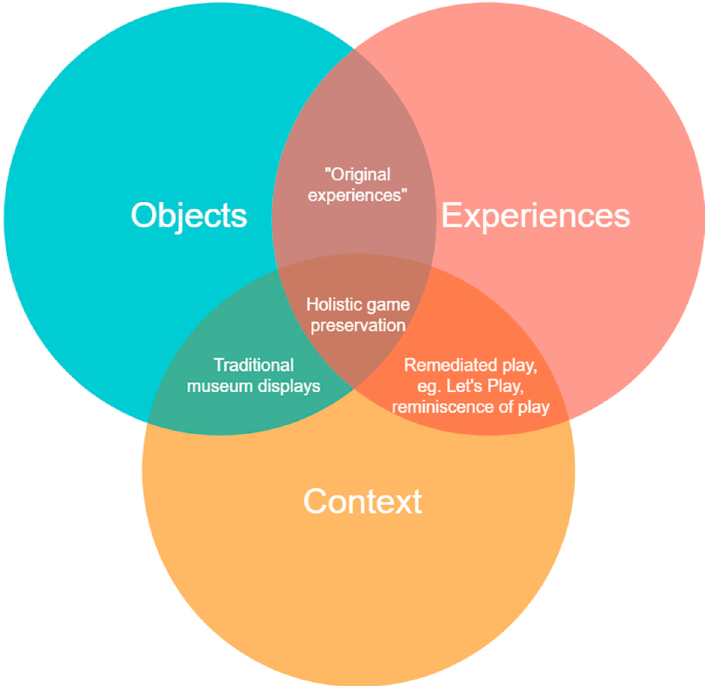
Figure 2. Games as objects, experiences, and context.